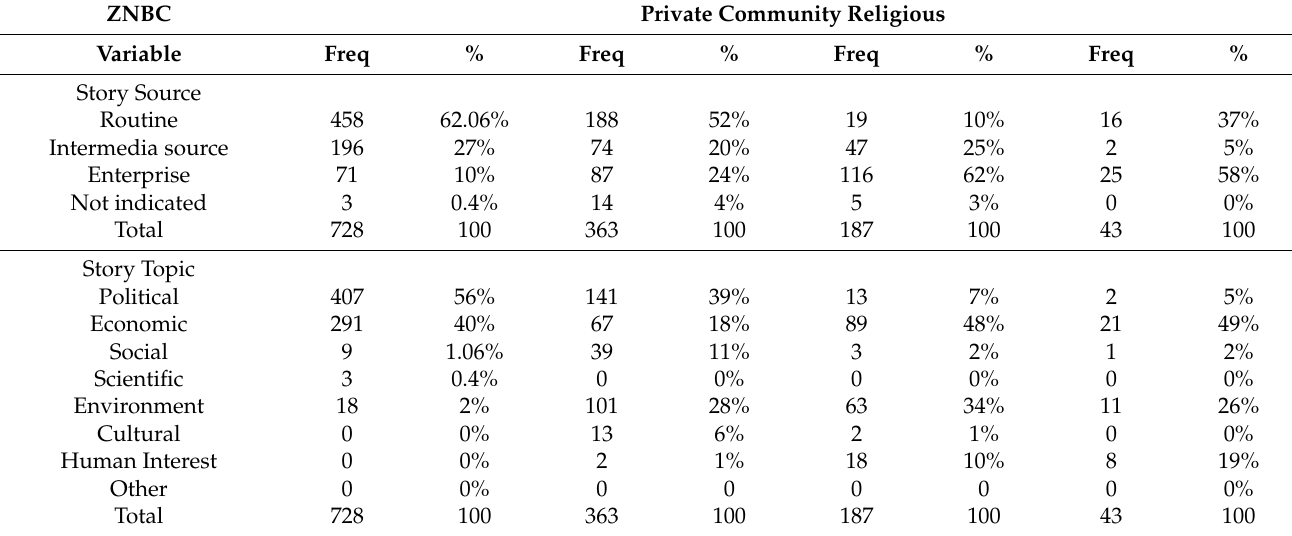
Table 1. Overall sample